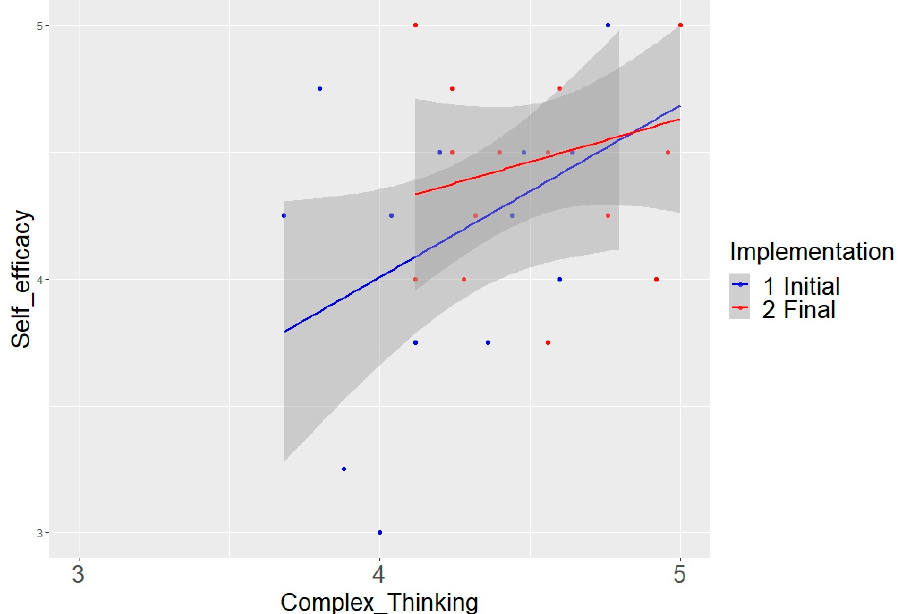
Figure 7. Correlation results of self ‐ efficacy and complex thinking competencies.